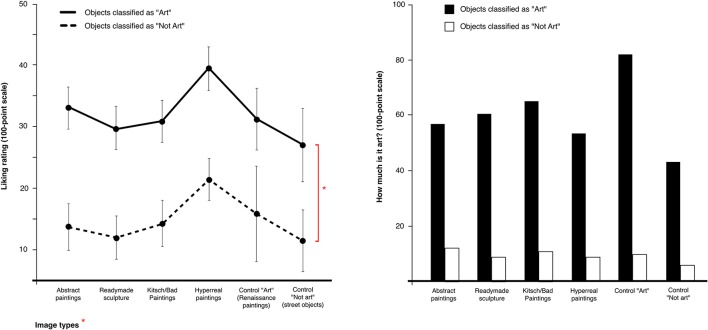
Difference in liking rating of image types based on classification as “Art” or “Not Art.” (*Repeated measures ANOVA: Arthood (yes/no) × category type (Abstract, Readymade, Hyperreal, Kitsch/Bad, Renaissance, Photos of everyday objects): significant main effect for Arthood F(1) = 33.42, p < 0.001, pη2 = 0.71, and for category type, F(5) = 3.46, p = 0.008, pη2 = 0.20).